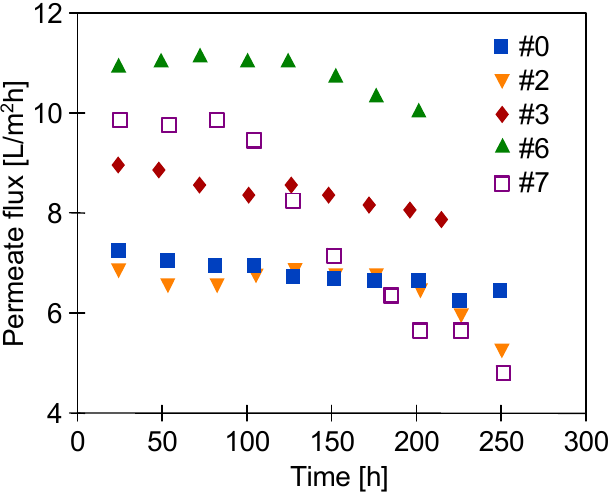
Figure 10. Changes in permeate flux during long-term water desalination by the MD process. One year after plasma treatment.